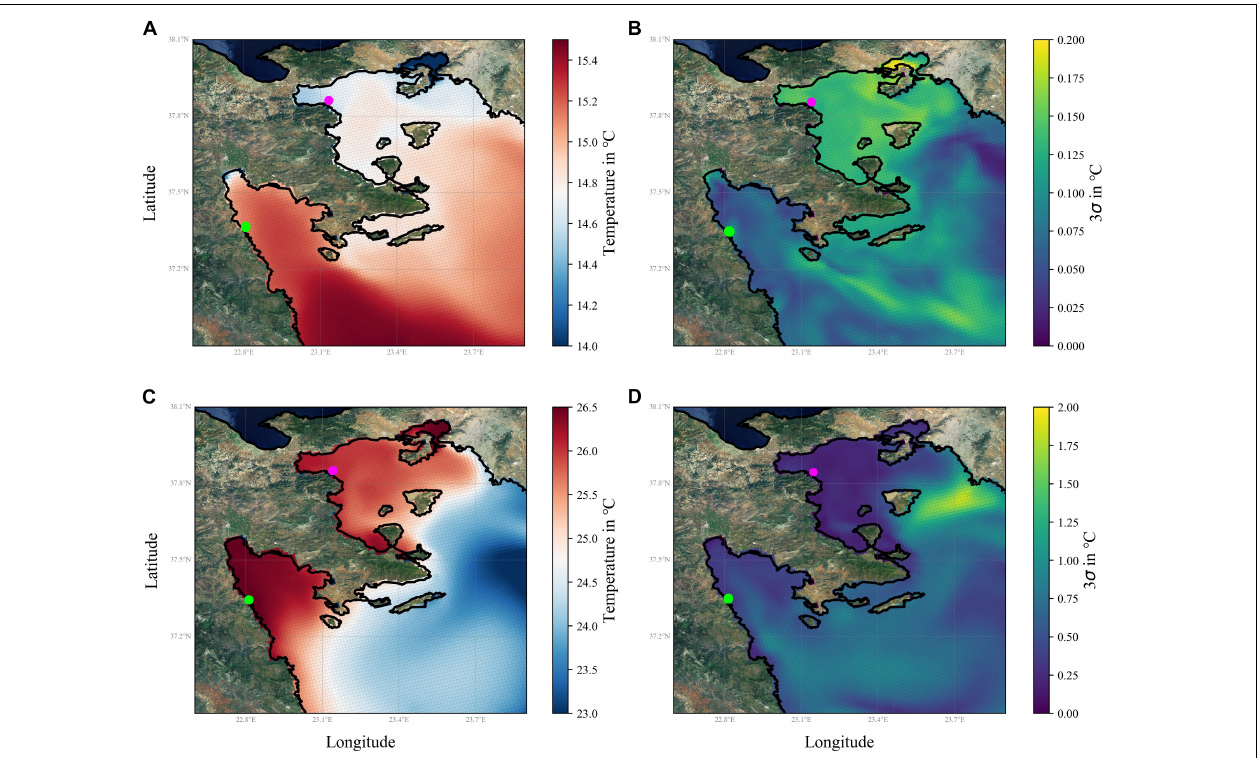
FIGURE 4 | Ensemble mean and ensemble spread of SWT with two aquaculture farms marked – Ortholithi (Green dot) and Ovrios (Magenta dot) (A) monthly mean March 2017, (B) 3 standard deviations ( σ ) March 2017, (C) monthly mean August 2017, and (D) 3 σ August 2017.